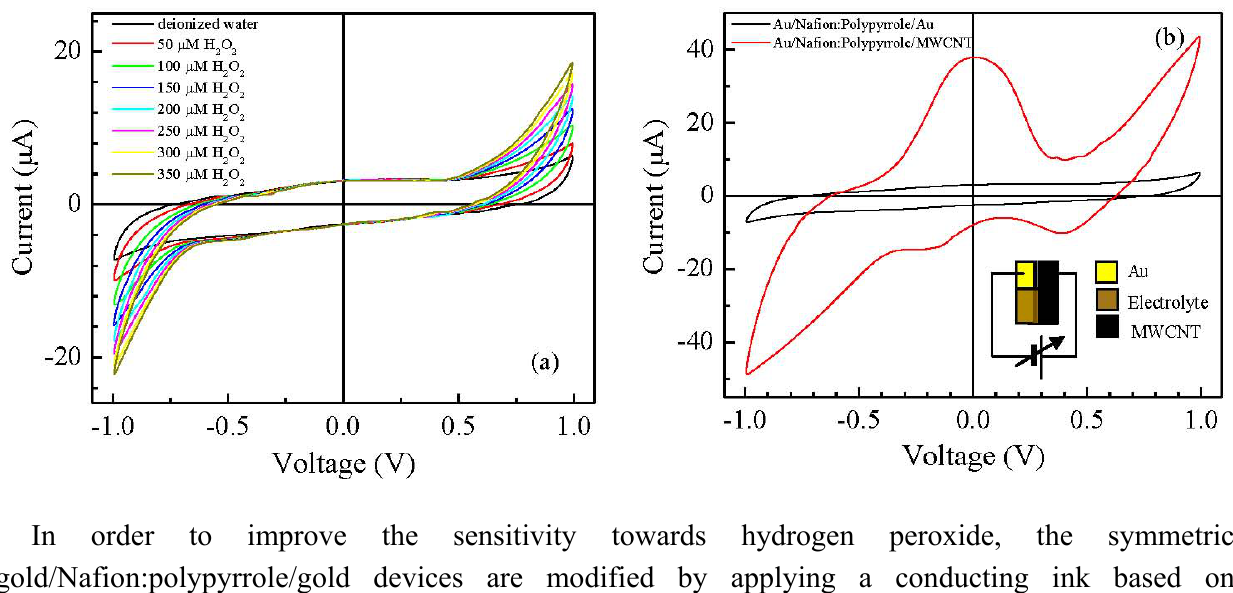
Figure 5. ( a ) Steady state current-voltage cycles of a typical gold/Nafion:polypyrrole/gold device, measured in distilled deionized water (black line), and in the presence of increasing O ; ( b ) Current-voltage cycle of a typical gold/Nafion:polypyrrole/gold cell, amounts of H 2 2 compared to the I–V cycle of a typical gold/Nafion:polypyrrole/MWCNTs cell. Both the curves are measured in steady state, in deionized water. The inset in the right bottom of the figure shows the schematic view of the gold/Nafion:polypyrrole/MWCNTs cell and the voltage